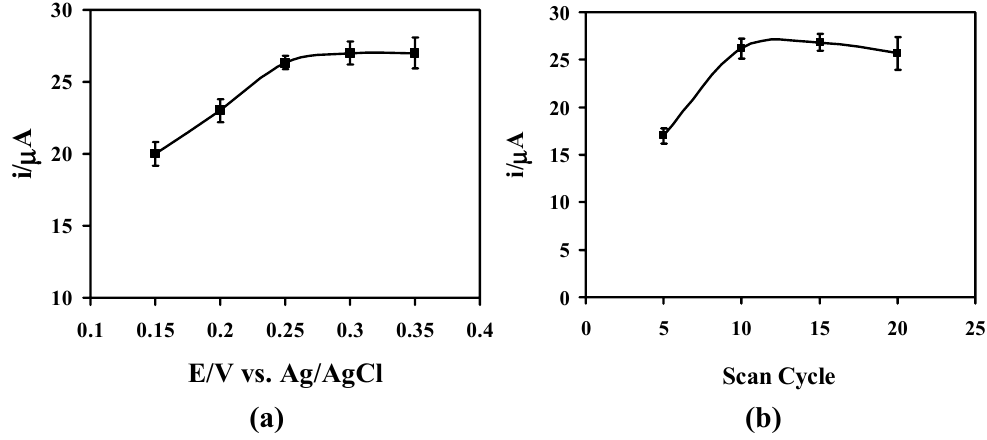
Figure 4. The optimization of the applied potential (a) and scan number (b) for electrocatalytic oxidation of AA at the poly(Ani- co - m -FcAni)/GCE in 0.1 M citrate buffer (pH 5.0) at scan rate of 50 mV s − 1 (n =